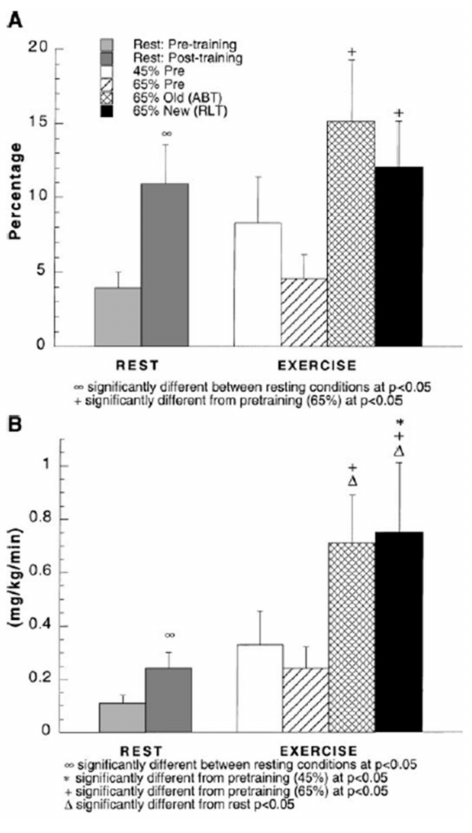
Figure 10. ( A ) Percent glucose appearance rate (Ra) from gluconeogenesis (GNG) during rest and exercise, before and after training. ( B ) Estimated GNG during rest and exercise, before and after training. Subjects were studied at 45 and 65% of peak rate of oxygen consumption (VO 2 peak) before 9 week of endurance training (45% pre and 65% pre, respectively) and then after training at same absolute power output that elicited 65% VO 2 peak before training (65% old (absolute, ABT)) and same relative power output that elicited 65% VO 2 peak after training (65% new (relative, RLT)). Values are means ± SE; n = 8–9. Although most lactate formed during steady rate exercise is disposed of within working skeletal muscle and elsewhere in the body such as heart [44,46,48], gluconeogenesis (GNG) accounts for 20–25% of lactate disposal during exercise. Hence, GNG is a major avenue of lactate disposal and the most important GNG precursor during exercise. From